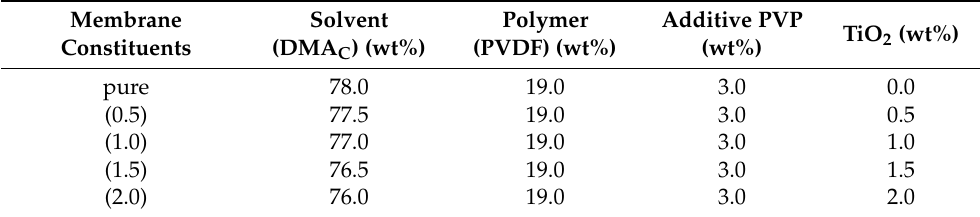
Table 1. Dope chemical